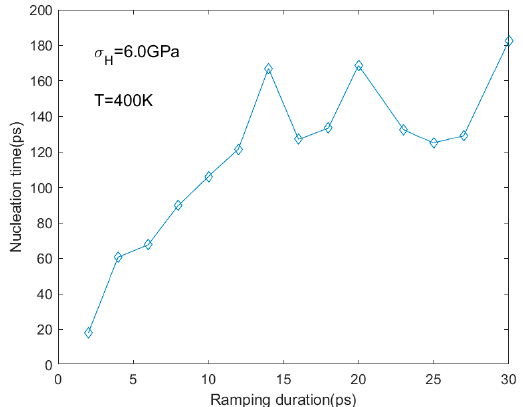
Figure A1. Void nucleation time, measured as time required for the simulation cell volume to increase by 10% during the holding phase, as a function of ramping duration.